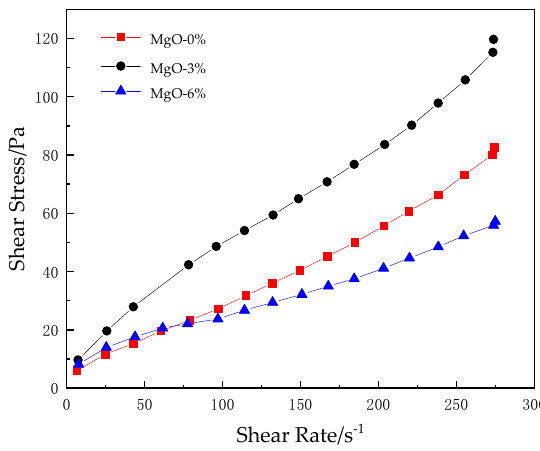
Figure 4. Shear stress as a function of shear rate.